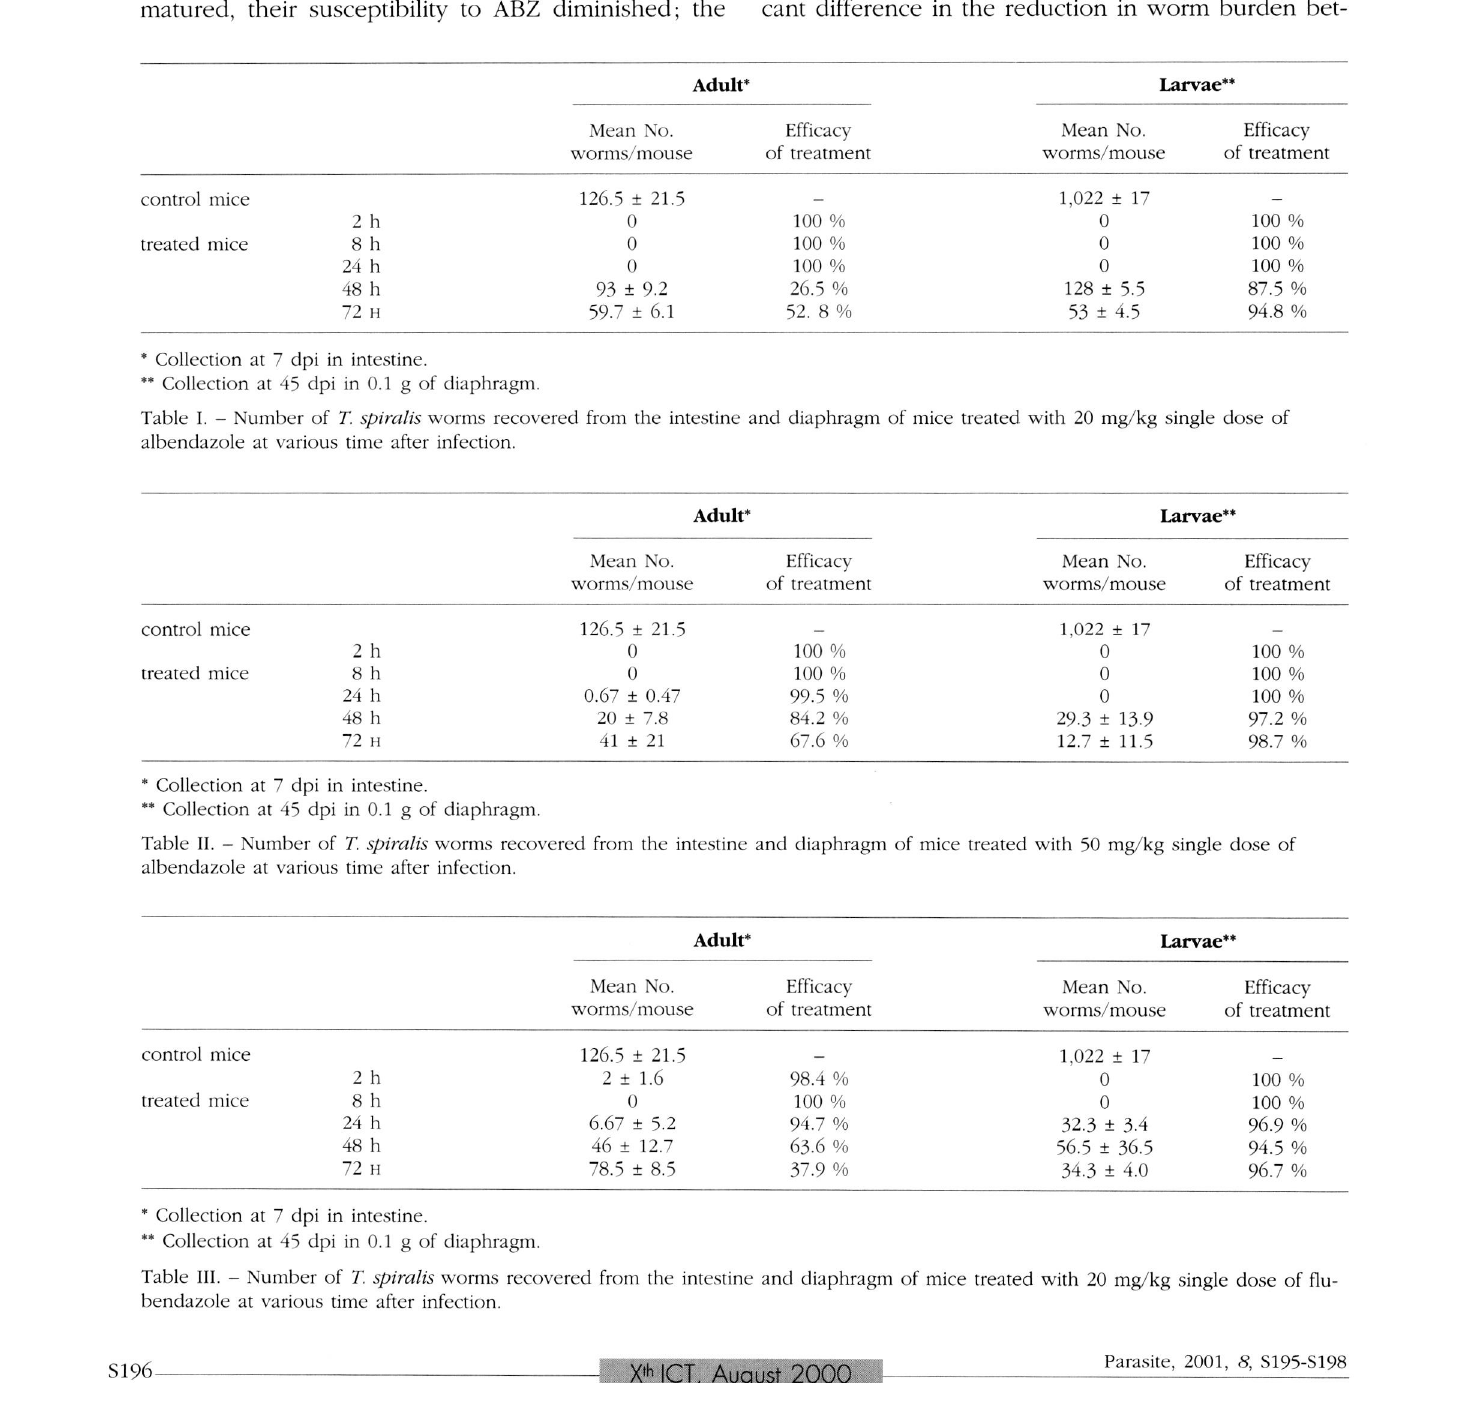
Table III. - Number of T. spiralis worms recovered from the intestine and diaphragm of mice treated with 20 mg/kg single dose of flu bendazole at various time after infection.